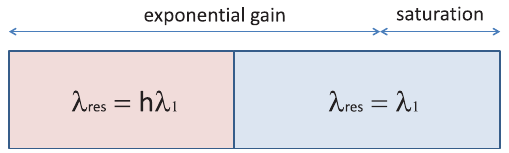
FIG. 3. Conceptual scheme of a harmonic lasing self-seeded